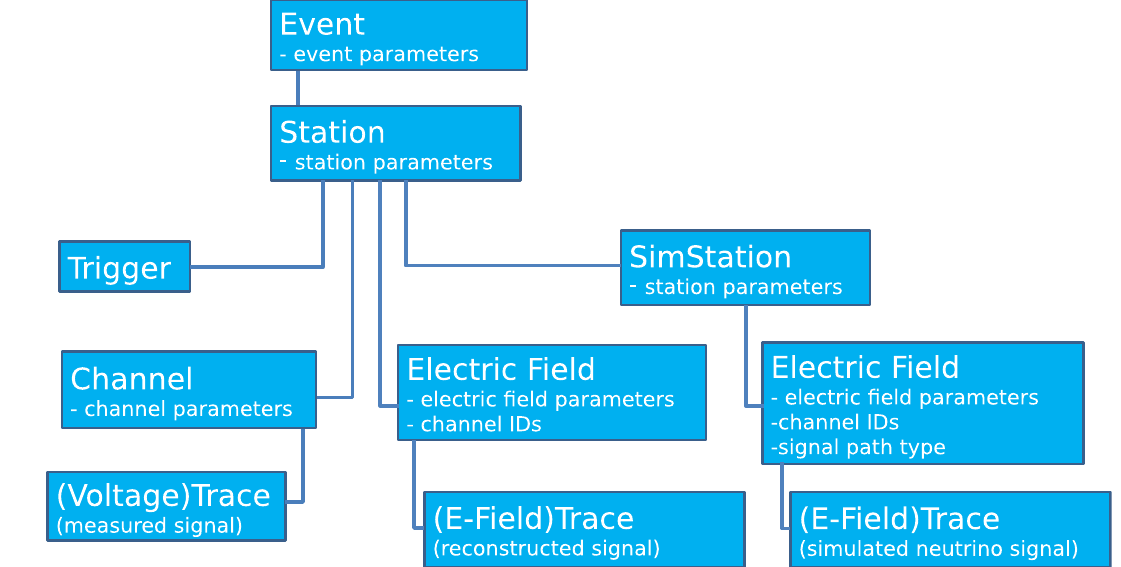
Fig. 2 Event structure as used in NuRadioReco. NuRadioReco uses the event as basic hierarchical structure. Every event contains stations and can be broken down to the waveforms in the voltage